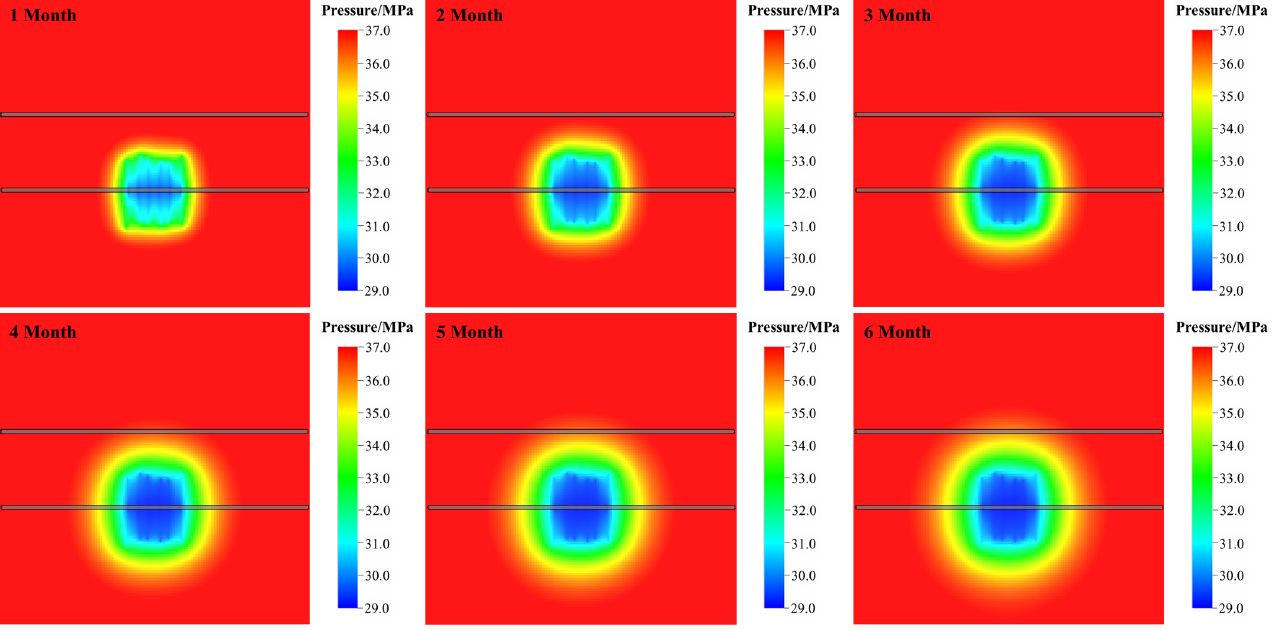
Figure 11. Reservoir pressure variation at different production times.